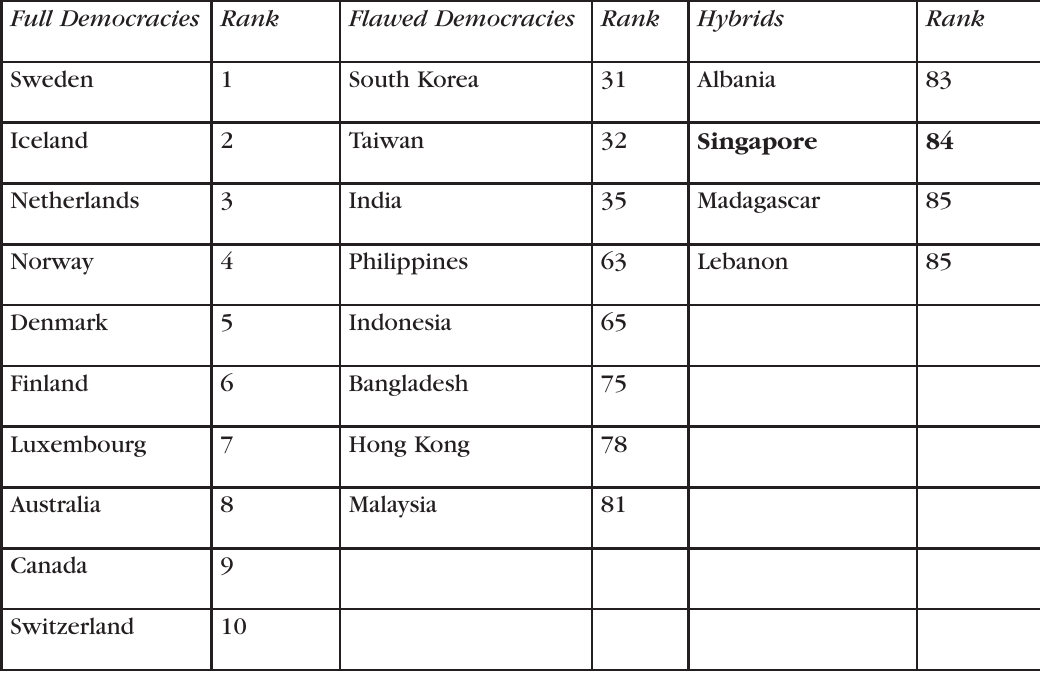
Table 3. Democracy Index 2007: The Economist Intelligence